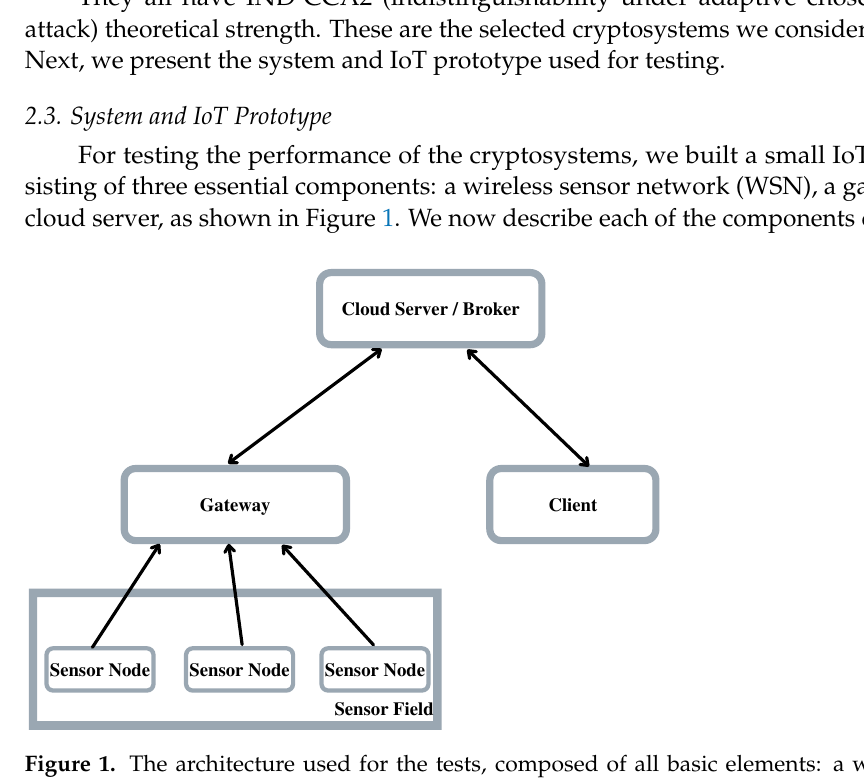
Figure 1. The architecture used for the tests, composed of all basic elements: a wireless sensor network, a gateway, and a cloud